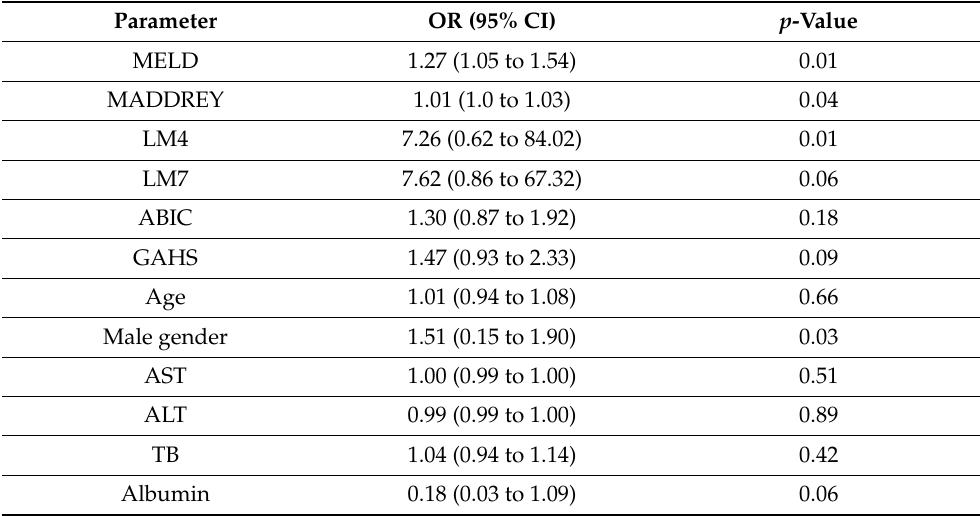
Table 2. Univariate logistic regression of factors associated with mortality.